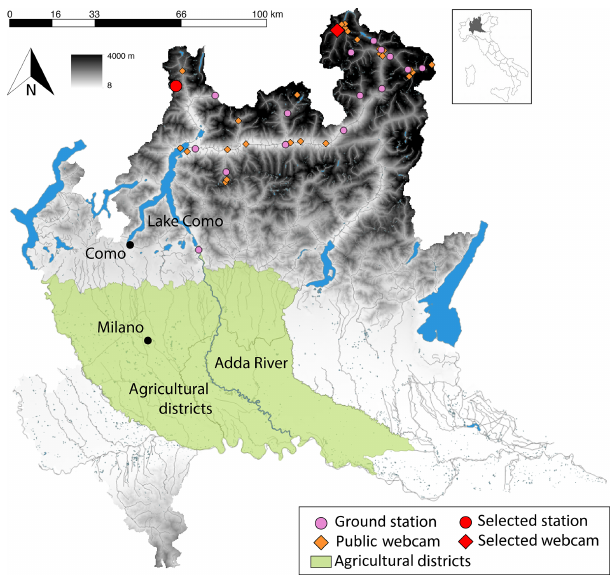
Figure 5. Adda River basin: Lake Como, Adda River, downstream agricultural districts, ground stations, and public